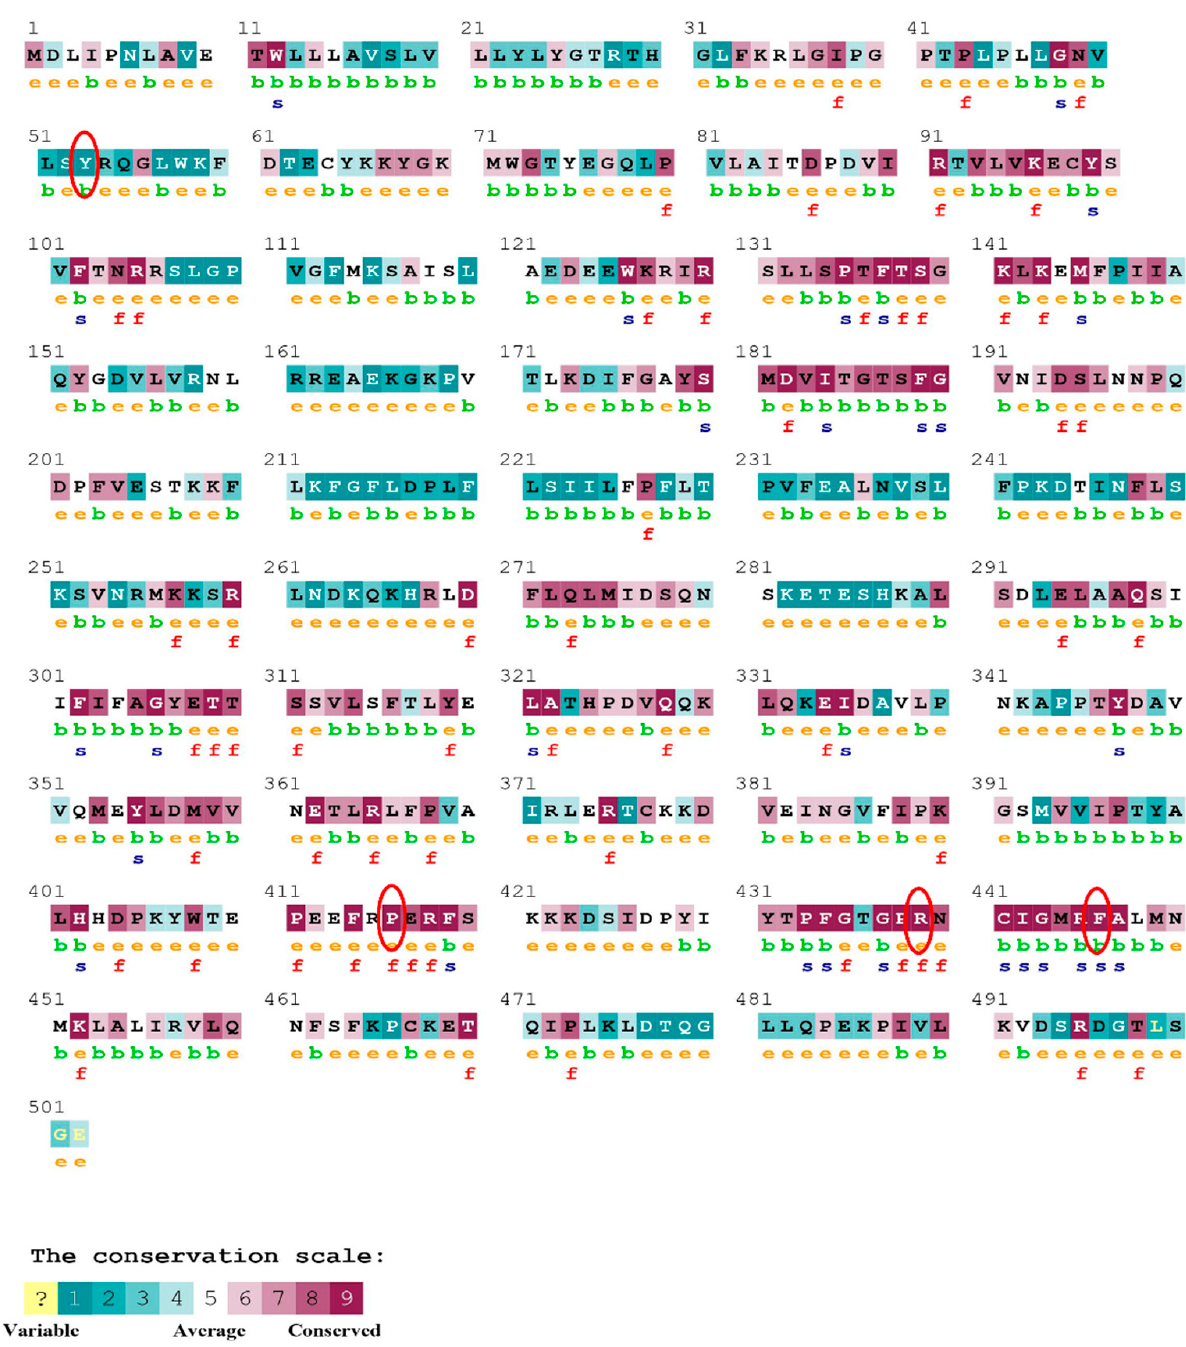
Figure 9. The ConSurf server predicted conserved amino acids in the CYP3A5 protein. Based on the conservation scale, the amnio acids are ranked as variable, average, and conserved.